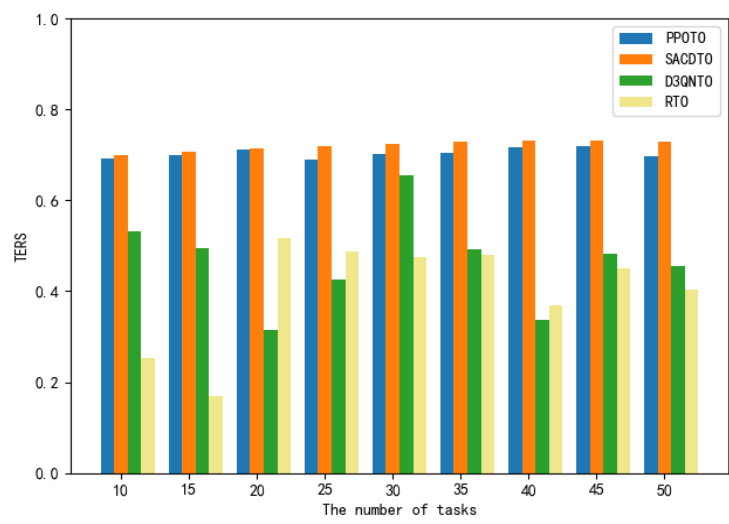
Figure 3. The Effect of Number of Devices on Delay.